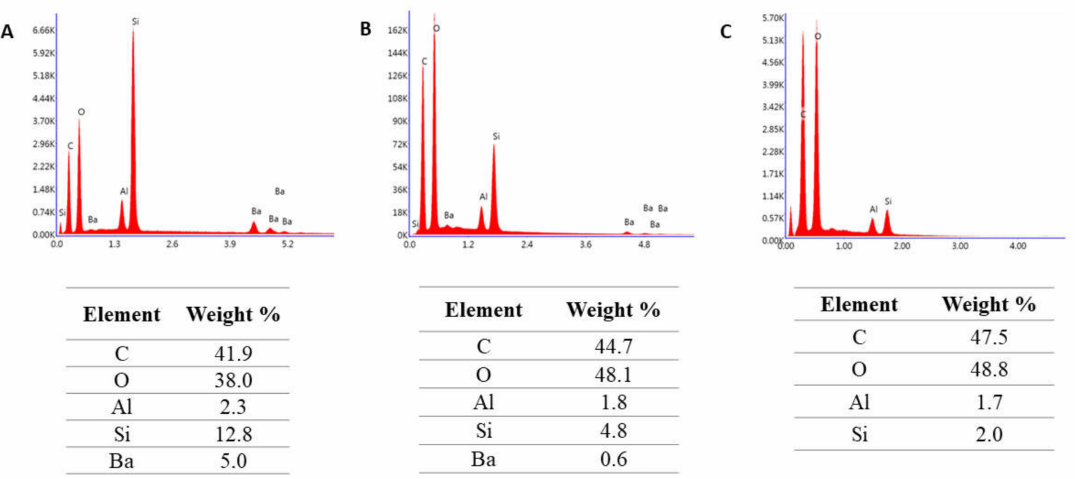
Figure 2. Chemical composition analysis of Flow-Art material after ( A ) Protocol 1 (24 h, 37 ◦ C, distilled water), ( B ) Protocol 2 (three months, 37 ◦ C, artificial saliva), ( C ) after Protocol 5 (1 week,